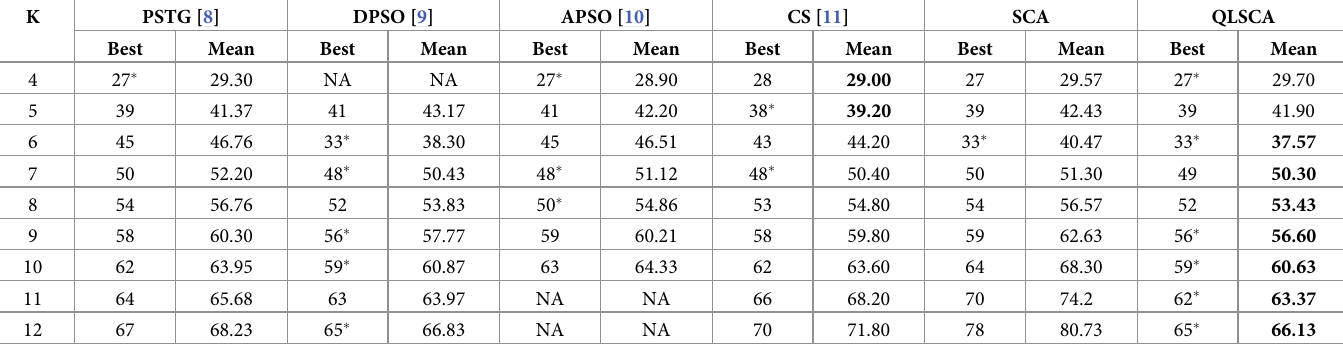
Table 5. Size performance for CA ( N ;3, 3 k ) where k is varied from 4 to